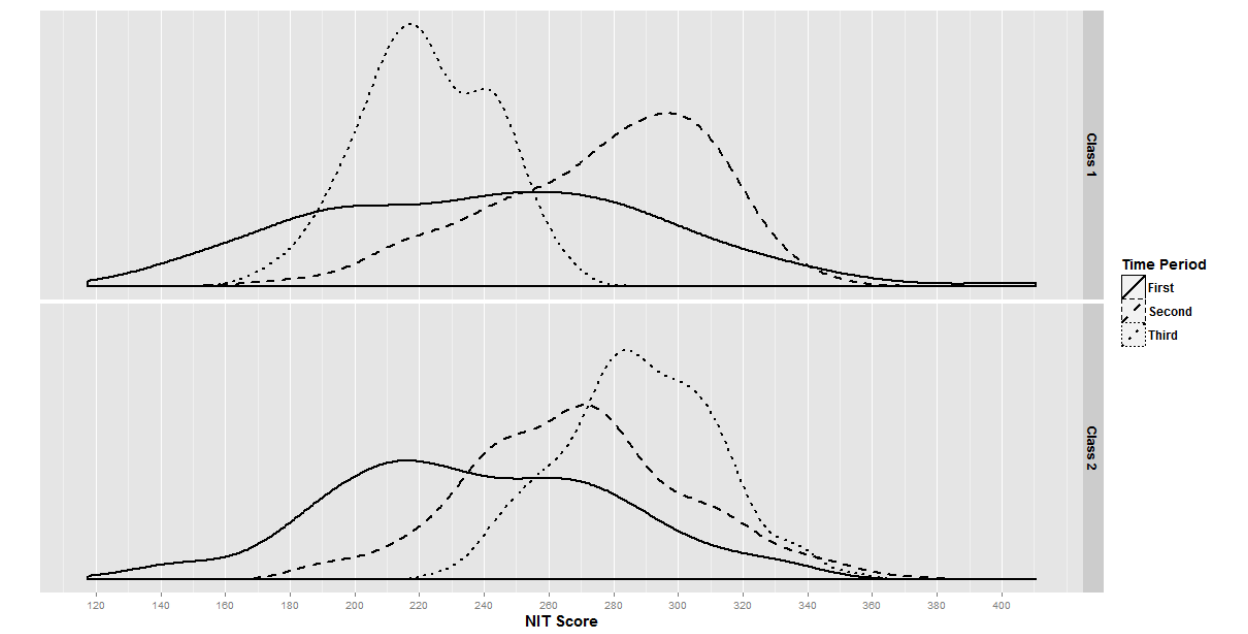
Figure 4. Distribution of National Intelligence Test scores for the three matched Estonian cohorts (1934, 1998 and 2006). The plotted score is the sum across the ten